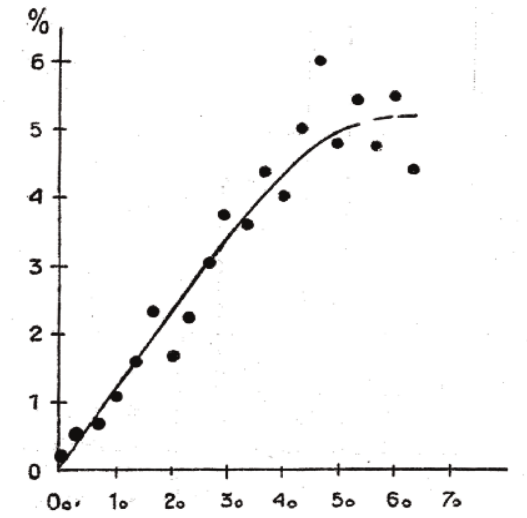
Figure 4. Fréquence d’apparition des pt pour chaque valeur du caractère Kp (d’après Yanagihara).